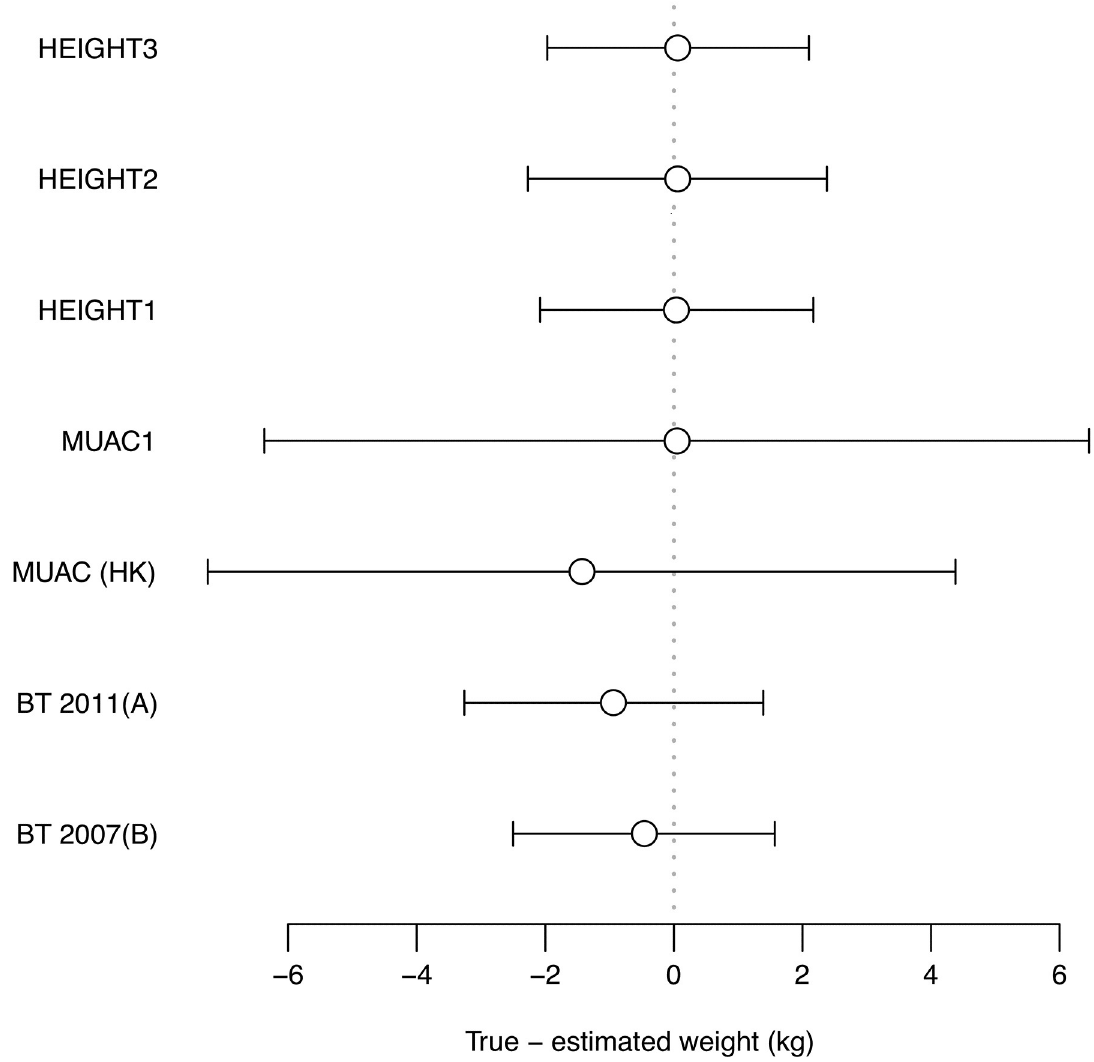
Fig 1. Forest plot showing Bland-Altman bias and 95% limits of agreement for weight estimation models. Bias (circles) is a measure of accuracy (lower absolute values = better accuracy). 95% LOA (error bars) is a measure of precision (narrower bars = better